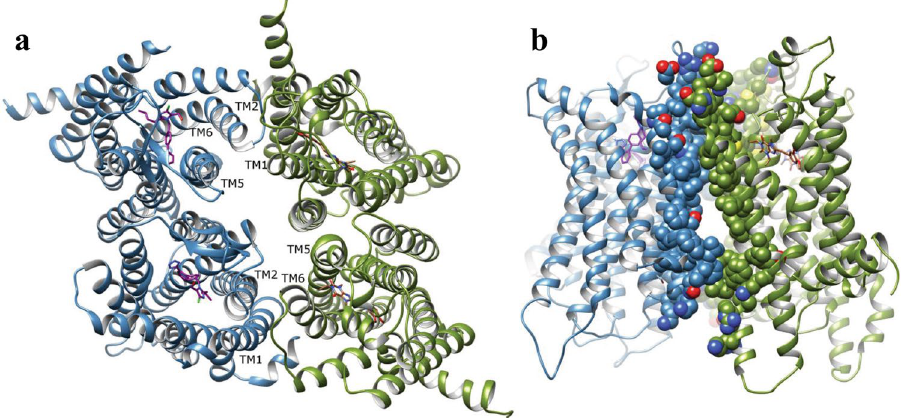
Figure 2. Conformational arrangement of AT 1 R/A 2A R heterotetramer. Model generated by protein-protein docking and 2 μ s MD simulation. ( a ) Top view of tetramer (AT 1 R in blue, A 2A R in green, losartan in purple and istradefylline in brown). ( b ) Side view of interaction between A 2A R and AT 1 R.